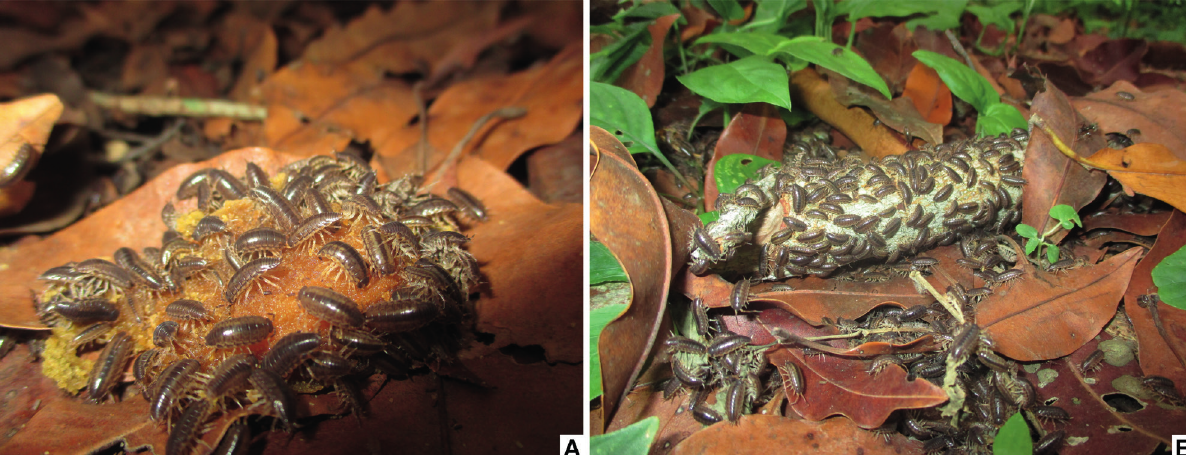
Figure 5. Pulmoniscus turbanaensis n. sp., Mameyal, Turbana. A. Specimens feeding on Manilkara sapota fruits; B. Specimens under piece of trees of Mammea americana , Mangifera indica and Manilkara sapota